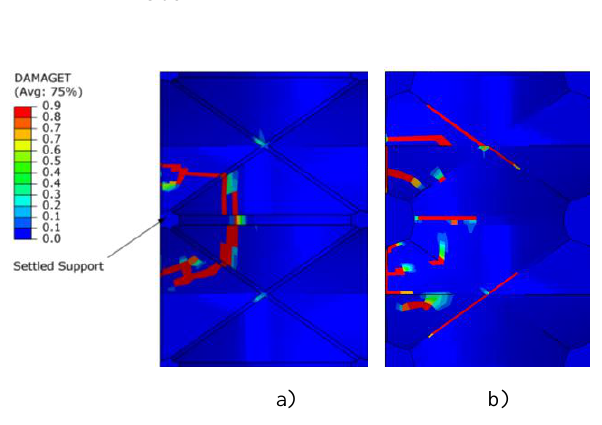
Figure 12. Damage simulation due to single vertical support settlement: a) intrados view, b) extrados view